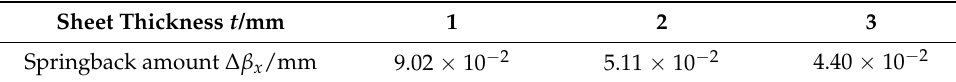
Table 9. Springback amount. Unit: mm.